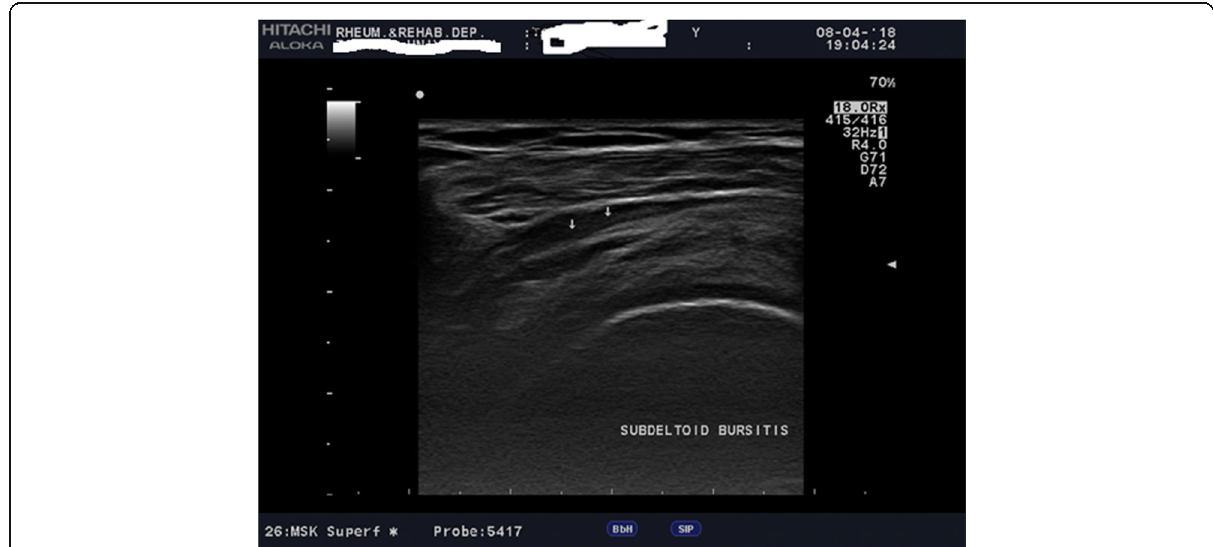
Fig. 4 Left subdeltoid bursitis. Longitudinal view of the left rotator cuff of the left shoulder joint. arrows showed hypoechoic area inside the subdeltoid bursa (synovial